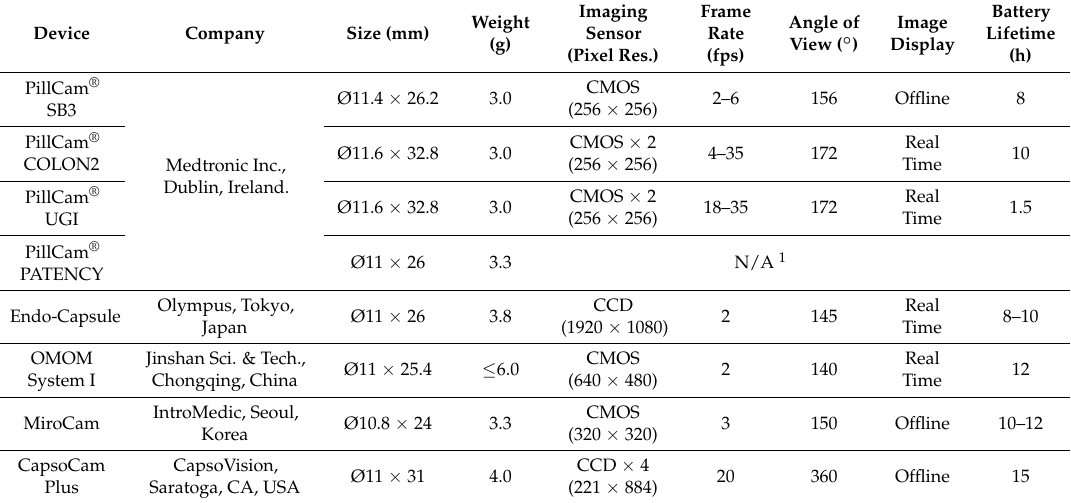
Table 1. Specifications of commercially available capsule endoscopes